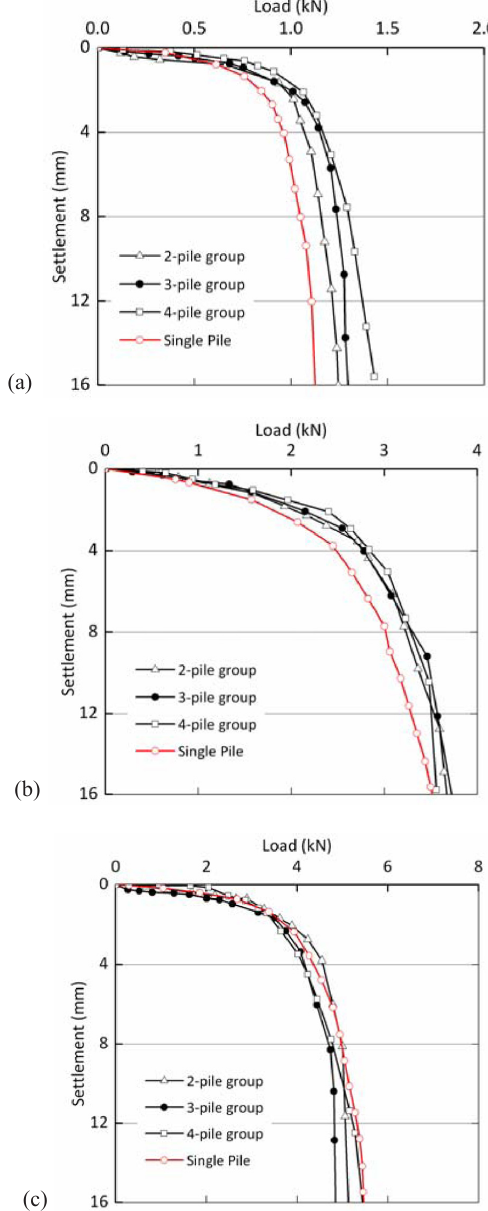
Fig. 9. Comparison of the capacity of a single model pile with those of the last model pile driven in each group ( S/B = 3): (a) loose sand; (b) medium dense sand; (c)